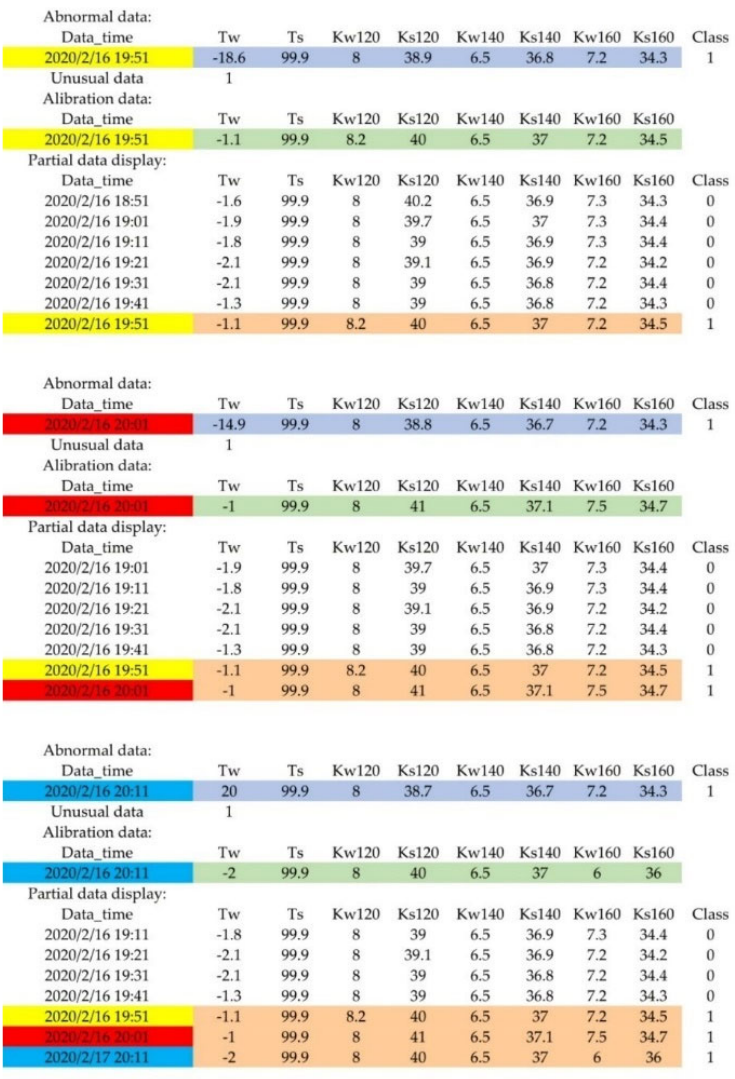
Figure 12. Results of abnormal data correction.